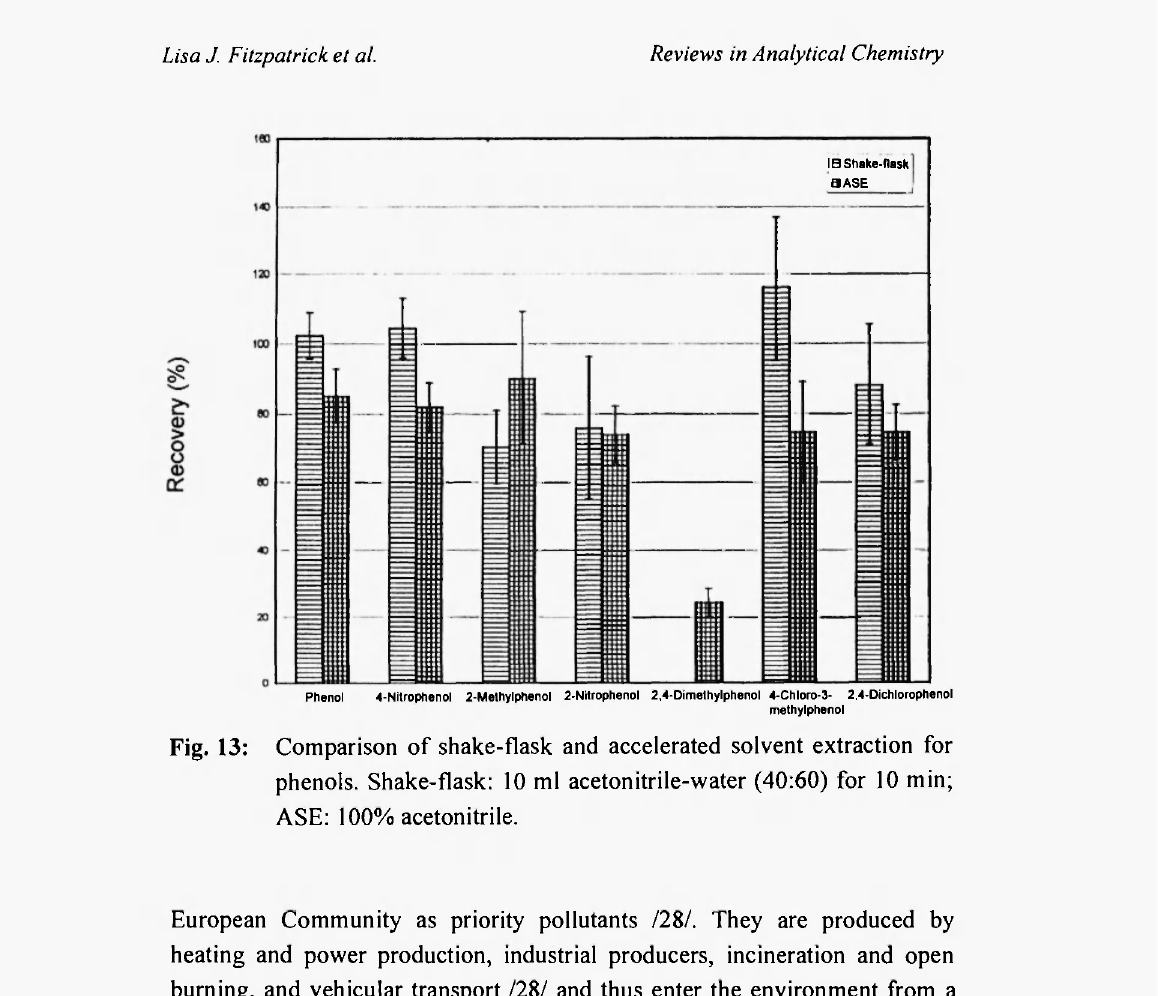
Fig. 13: Comparison of shake-flask and accelerated solvent extraction for phenols. Shake-flask: 10 ml acetonitrile-water (40:60) for 10 min; ASE: 100%